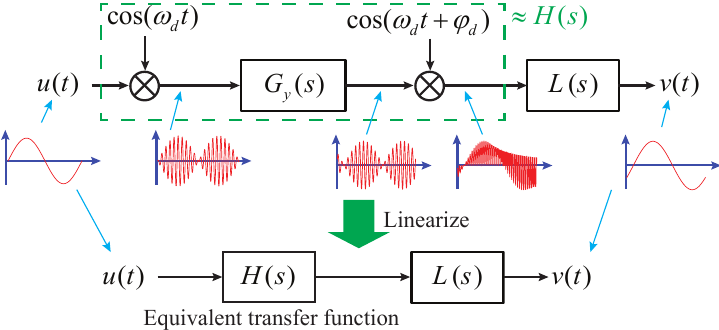
Figure 2. Equivalent transfer function of the modulation–demodulation process in the gyroscope sense